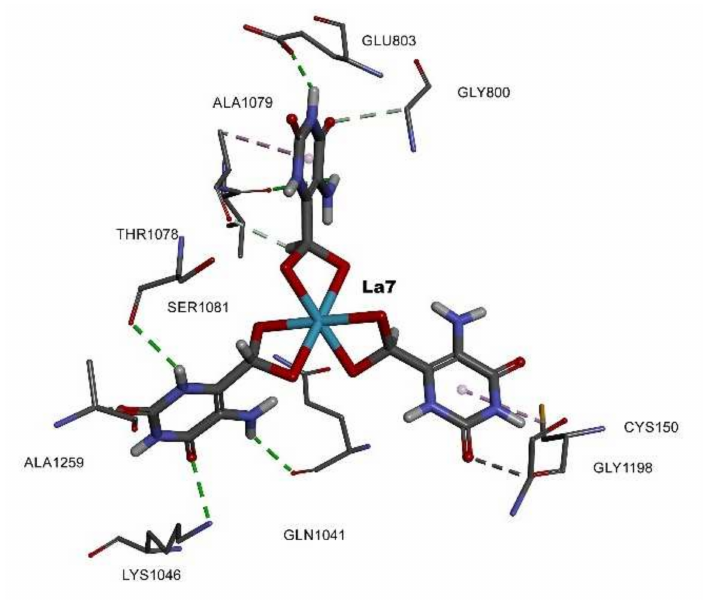
Figure 5. The 3D structure of the lanthanum (III) complex presented as sticks and colored by CPK with the involved amino acids inside the active site of the